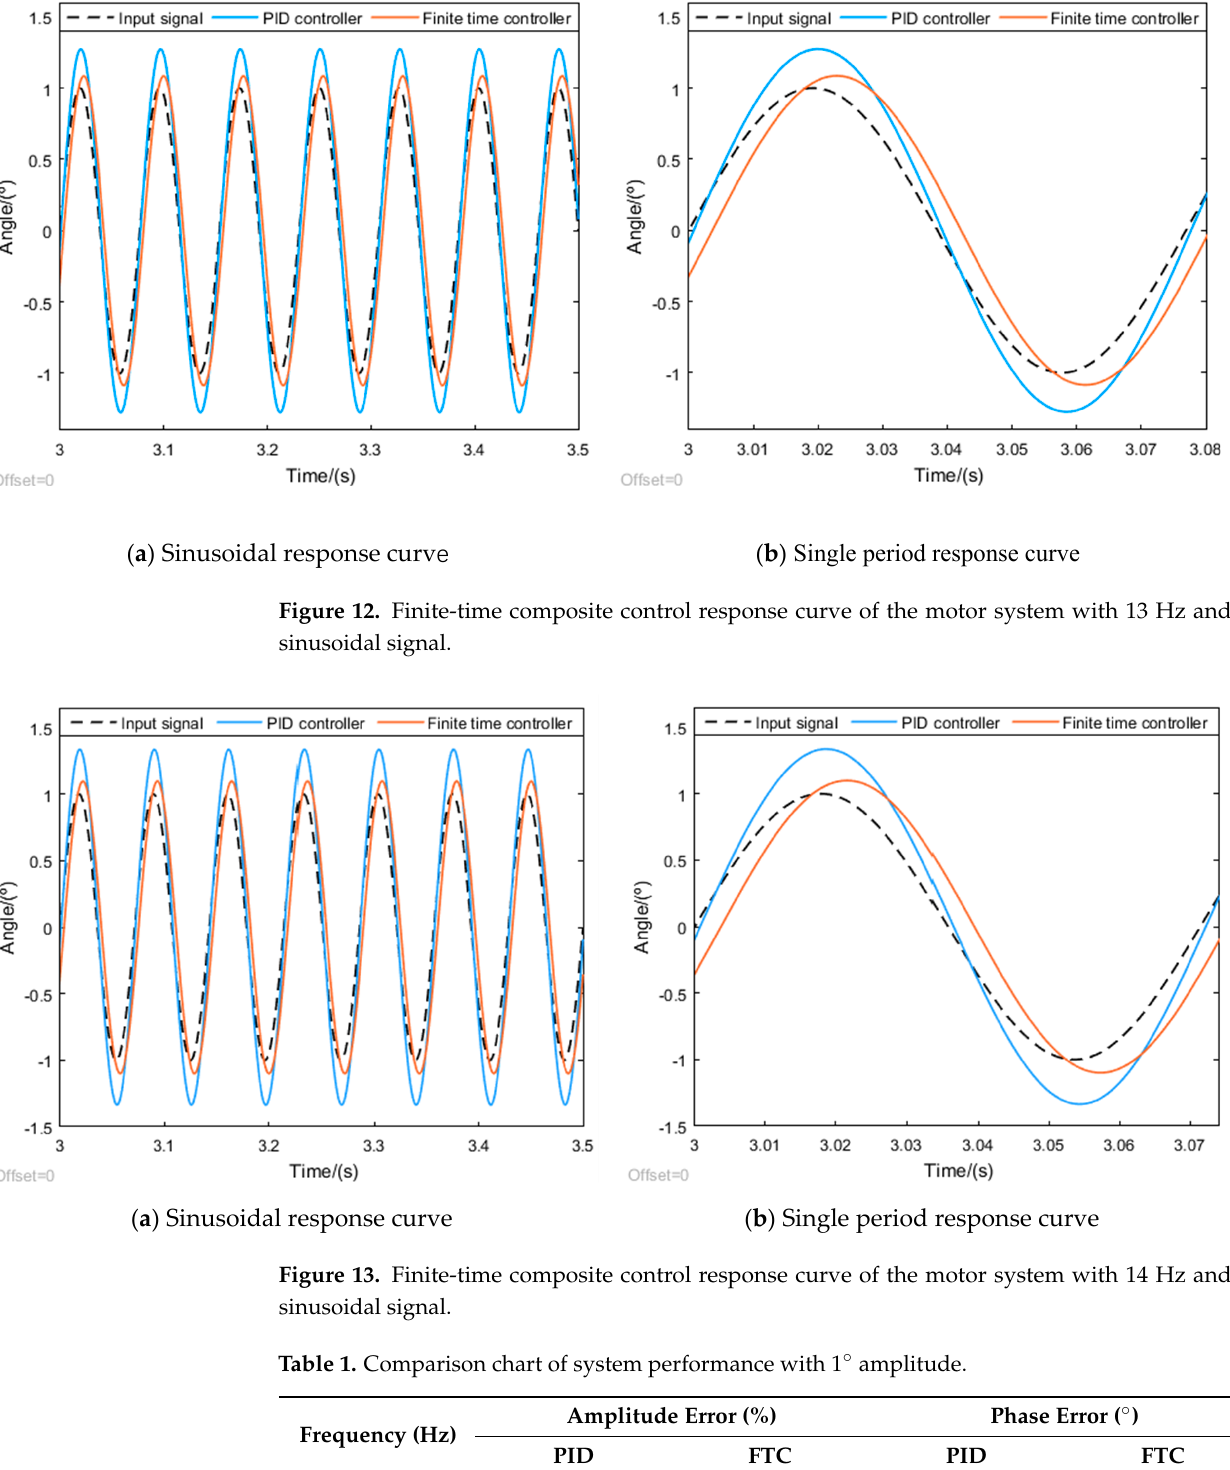
Figure 11. Finite-time composite control response curve of the motor system with 12 Hz and 1° sinusoidal signal.